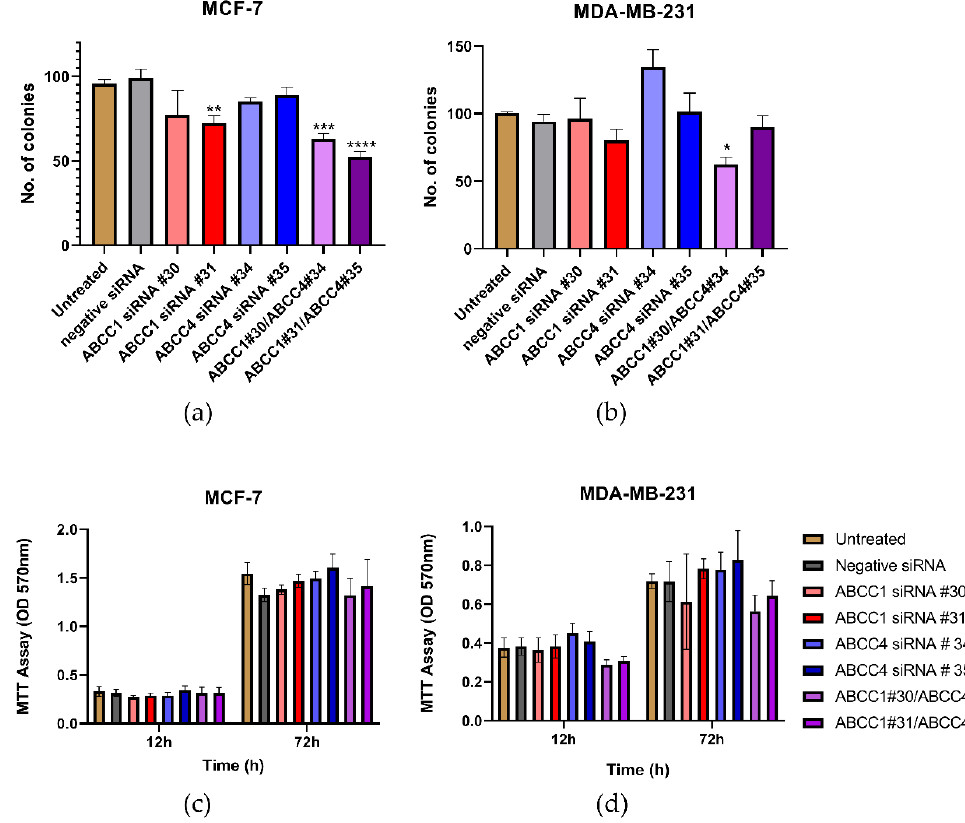
Figure 6. Combined knockdown of ABCC1 and ABCC4 a ff ects the clonogenic capacity of breast cancer cells. ( a , b ) Clonogenic capacity of breast cancer cells following the siRNA-mediated knockdown of ABCC1 or ABCC4 was analyzed using a colony formation assay. ( c , d ) Proliferation of breast cancer cells following the siRNA-mediated knockdown of ABCC1 or ABCC4 was analyzed using an MTT assay. Data are mean ± sem, n ≥ 6. Data were analyzed by an ANOVA with a Dunnett’s post hoc test. * p < 0.05, ** p < 0.01, *** p < 0.001 and **** p < 0.0001significantly lower than with the